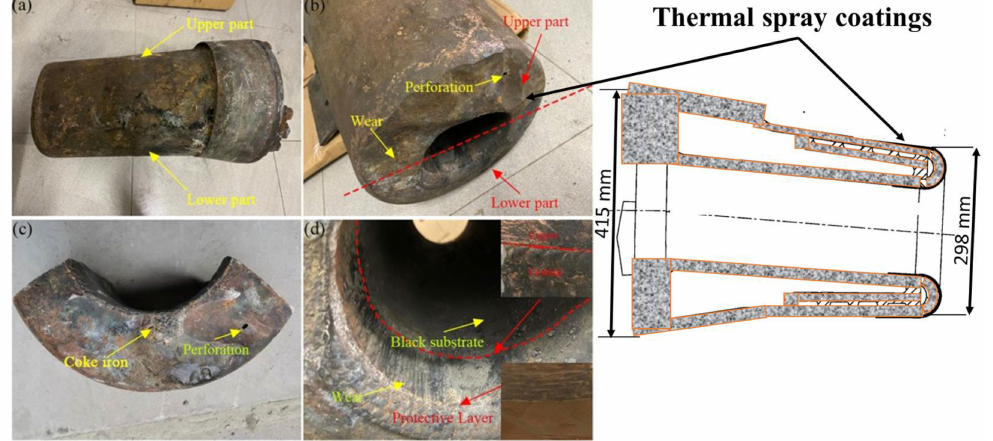
Figure 7. A typical application of thermal spray coatings in protecting blast furnace tuyeres, ( a , b ) over- all views, ( c ) front end, and ( d ) inner wall of a tuyere of blast furnace, adapted with permission from [29]. 2022,